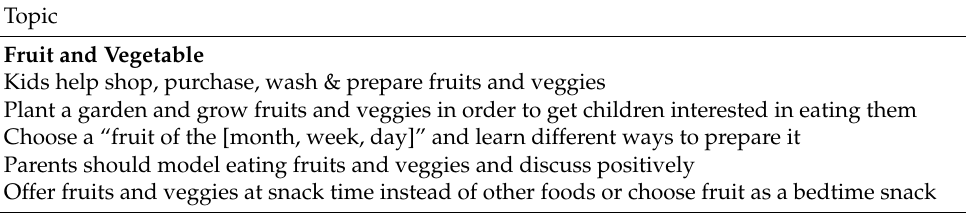
Table 1. Summary of the most highly ranked messages generated from Community Advisory Board meetings for fruit and vegetable consumption or physical activity home